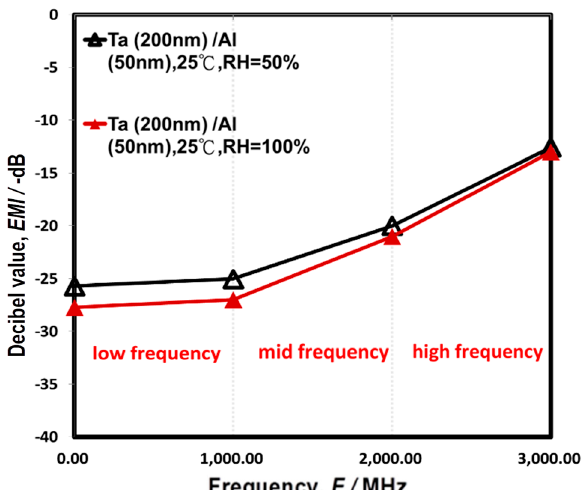
Figure 7. EMI shielding of Ta/Al/glass test sample with different humidities.